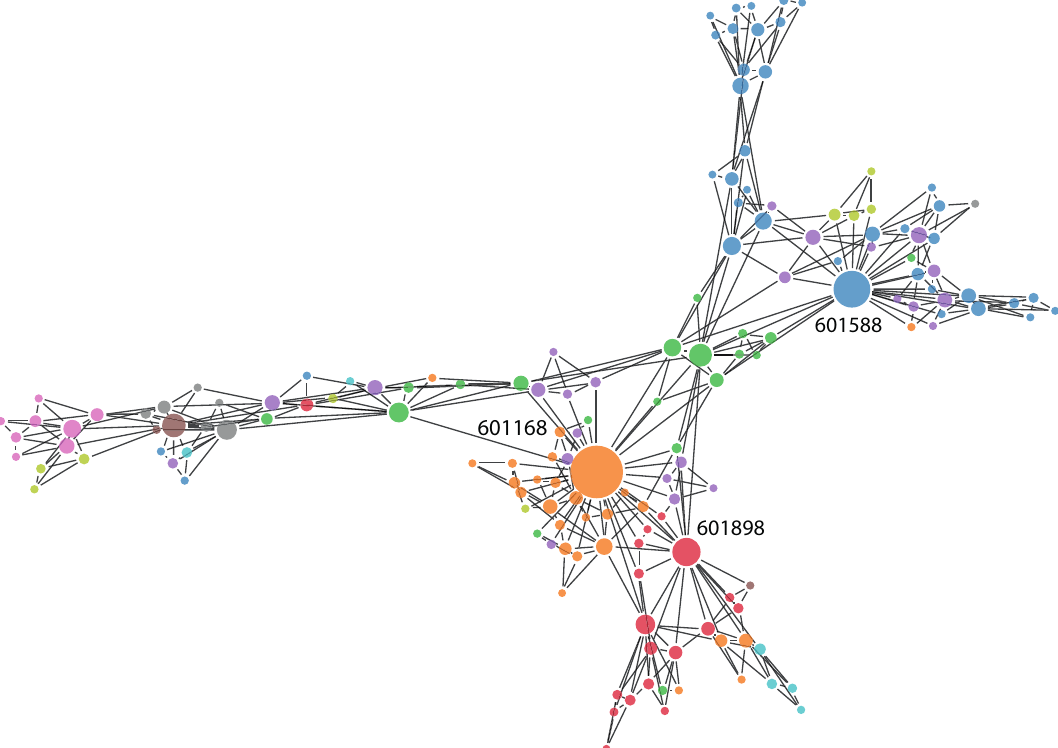
Figure 2. Planar maximally-filtered graph for the Shanghai Stock Exchange based on partial mutual information between studied stocks. Stocks with the highest node degrees have been named with their ticker symbols. The size of the nodes is proportional to their node